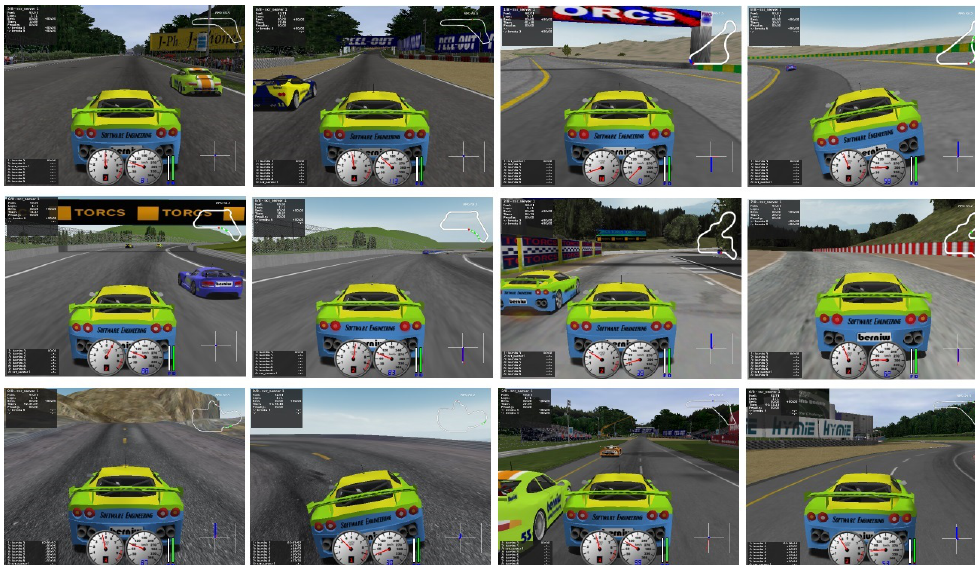
Figure 4. Examples of traffic scenarios from the five different tracks contained in our dataset.